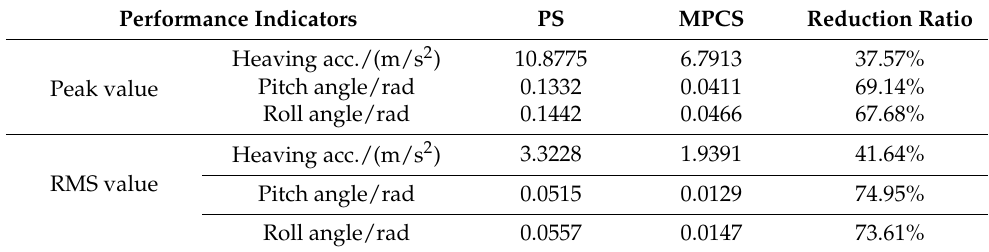
Table 5. Simulation results of Peak Value and RMS Value of attitude stability control under Random Road Disturbances.